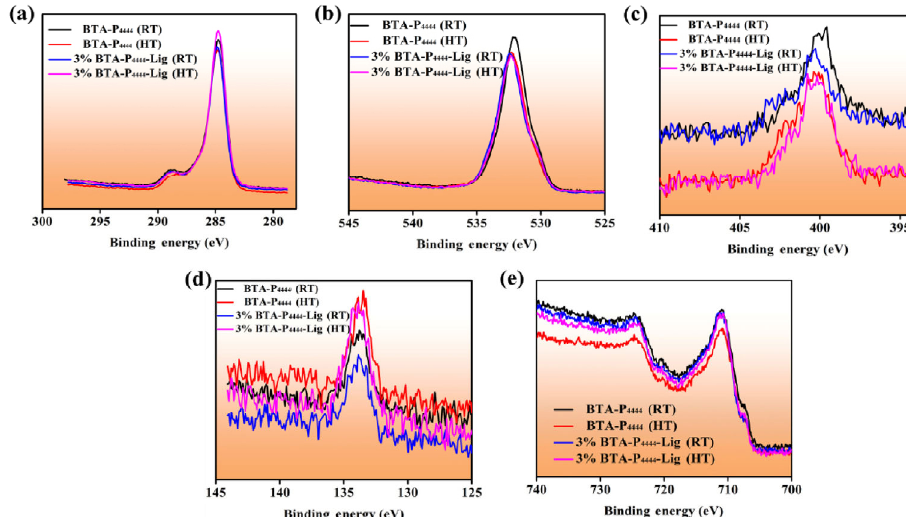
Fig. 9 XPS analysis: (a) C 1s; (b) O 1s; (c) N 1s; (d) P 2p; and (e) Fe 2p (RT and HT represent 50 and 150 °C,